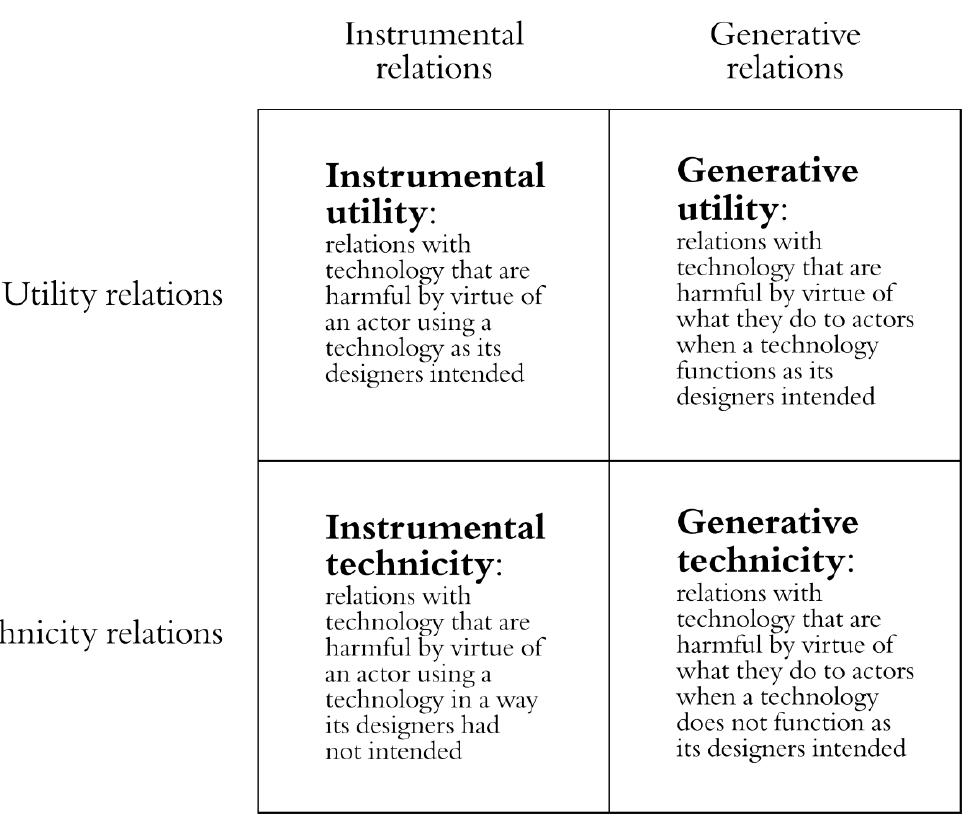
Figure 1. A typology of technology – harm